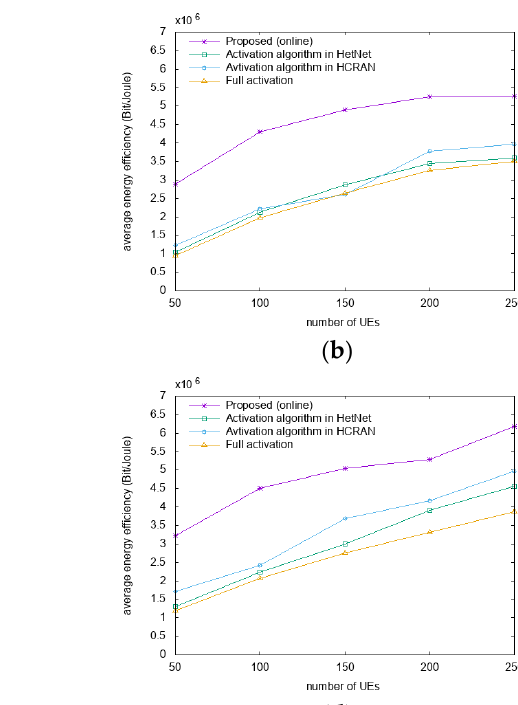
Figure 6. Comparison of the energy efficiencies in environments with 15 RRHs. ( a ) San Francisco and ( c ) Beijing datasets with Gaussian distributions; ( b ) San Francisco and ( d ) Beijing datasets with uniform distributions.